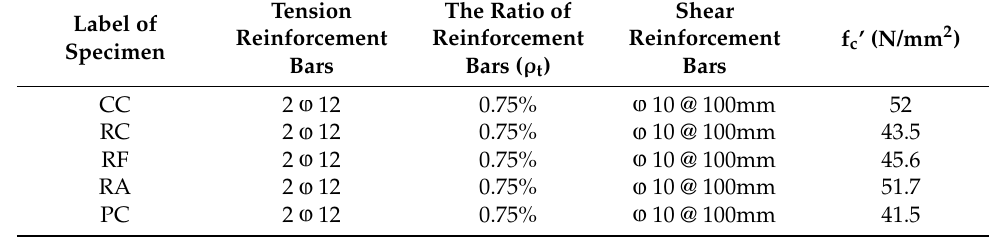
Table 3. Properties of reinforced concrete specimens .